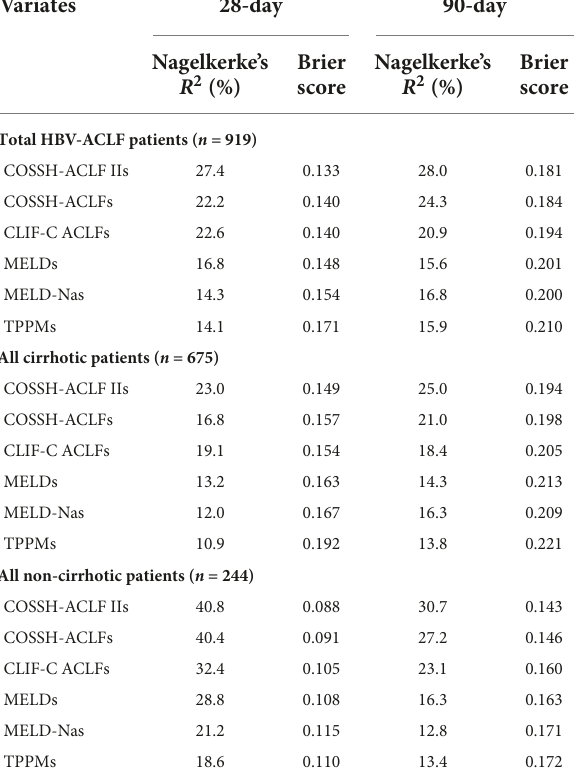
TABLE 4 Nagelkerke’s R 2 and Brier score of scoring models in patients with HBV–ACLF. Variates 28-day 90-day Nagelkerke’s Brier Nagelkerke’s Brier R 2 (%) R 2 (%) score